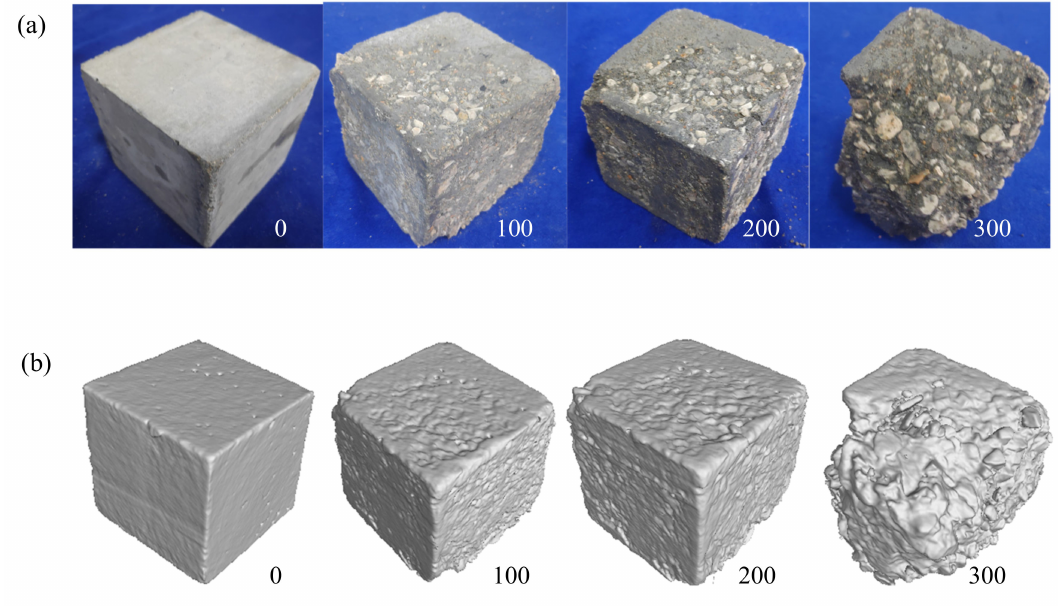
Figure 8. Morphologies and 3D reconstruction model of concrete: ( a ) morphologies; ( b ) 3D reconstruction